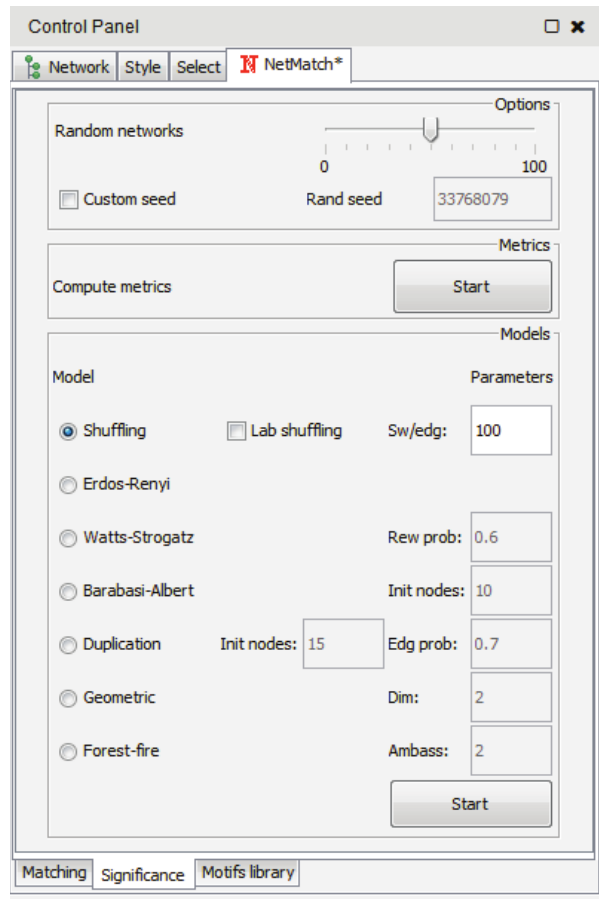
Figure 2. “Significance” panel in